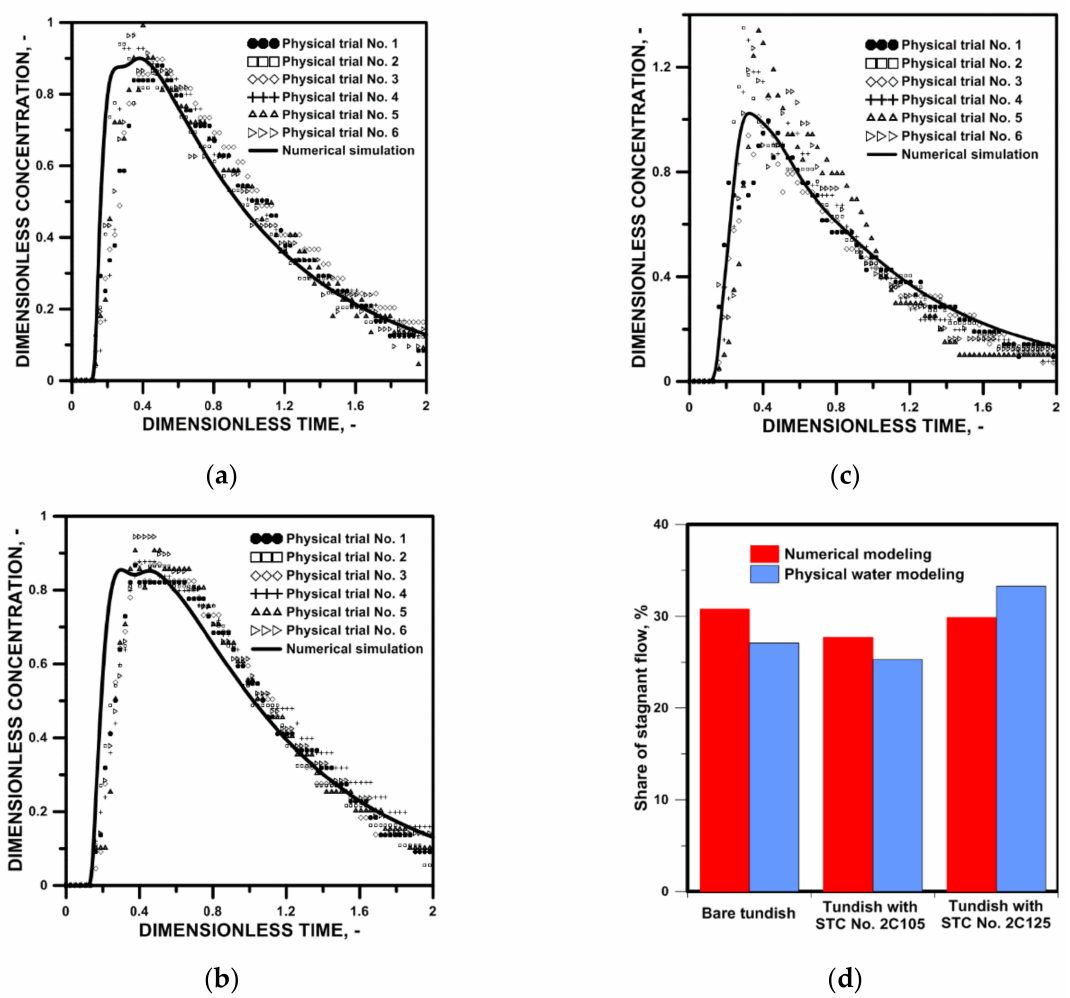
Figure 2. Physical water model trials: ( a ) E-type residence time distribution curve for bare tundish, ( b ) E-type residence time distribution curve for tundish with SFC No. 2C105, ( c ) E-type residence time distribution curve for tundish with SFC No. 2C125, ( d ) comparison of stagnant flow